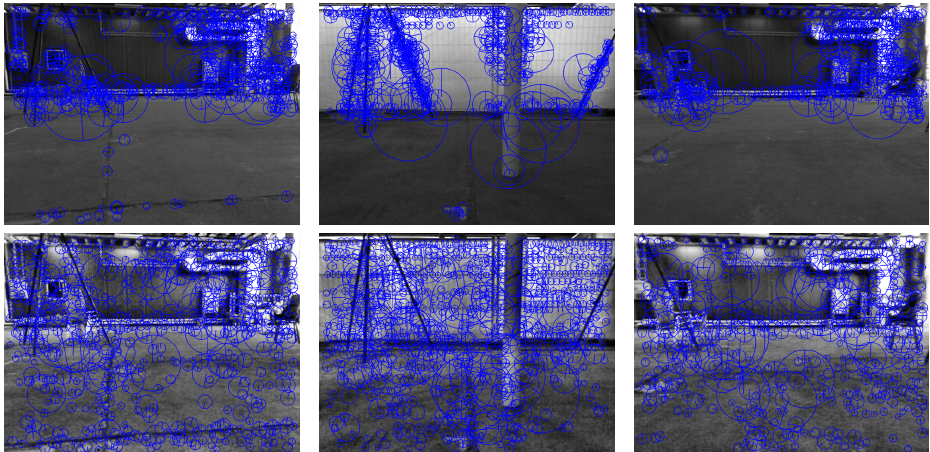
Figure 10. Three examples from TUM sequences showing the effect of CLAHE and SSC in indoor scenarios. The images in the top row show the images with the detected features using SURF, detected without the use of CLAHE and SSC algorithms. The images in the bottom row show the features detected by SURF after adding the CLAHE and SSC stages.